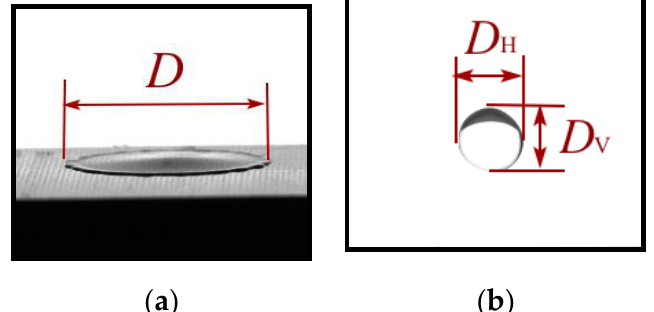
Figure 3. Parameters of droplet. ( a ) droplet spreading diameter. ( b ) droplet diameters in horizontal and vertical directions